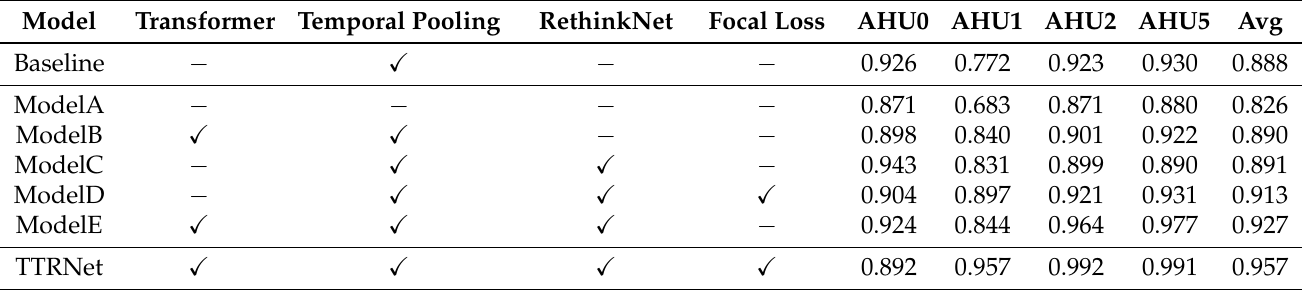
Table 8. Ablation studies of different components of TTRNet in the seen